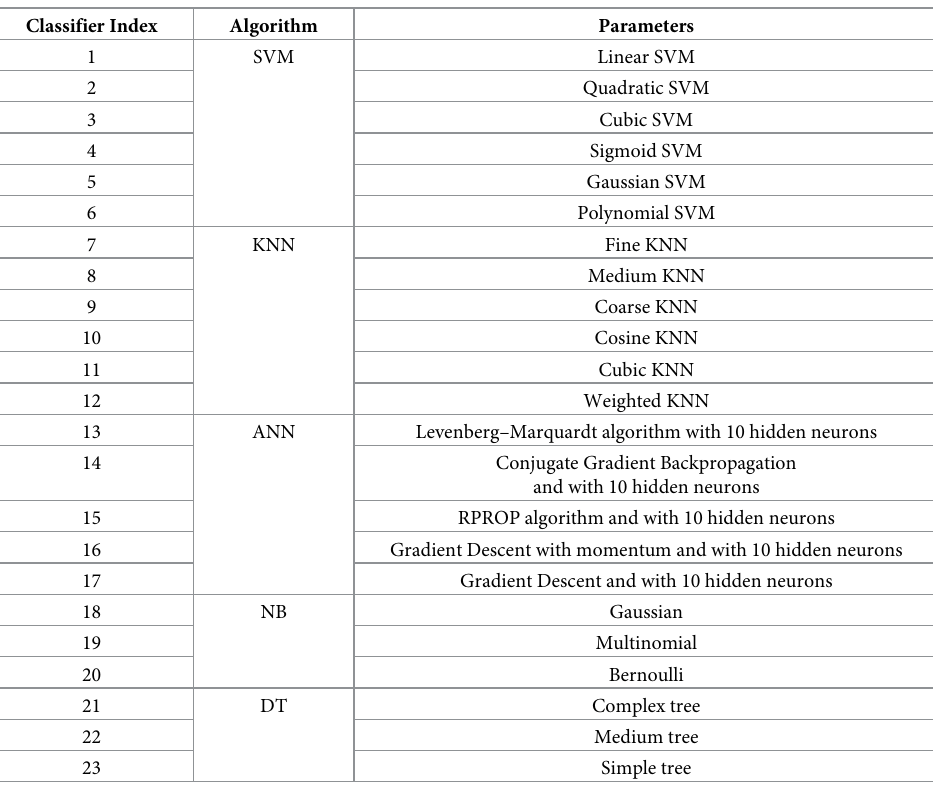
Table 5. Single-modality